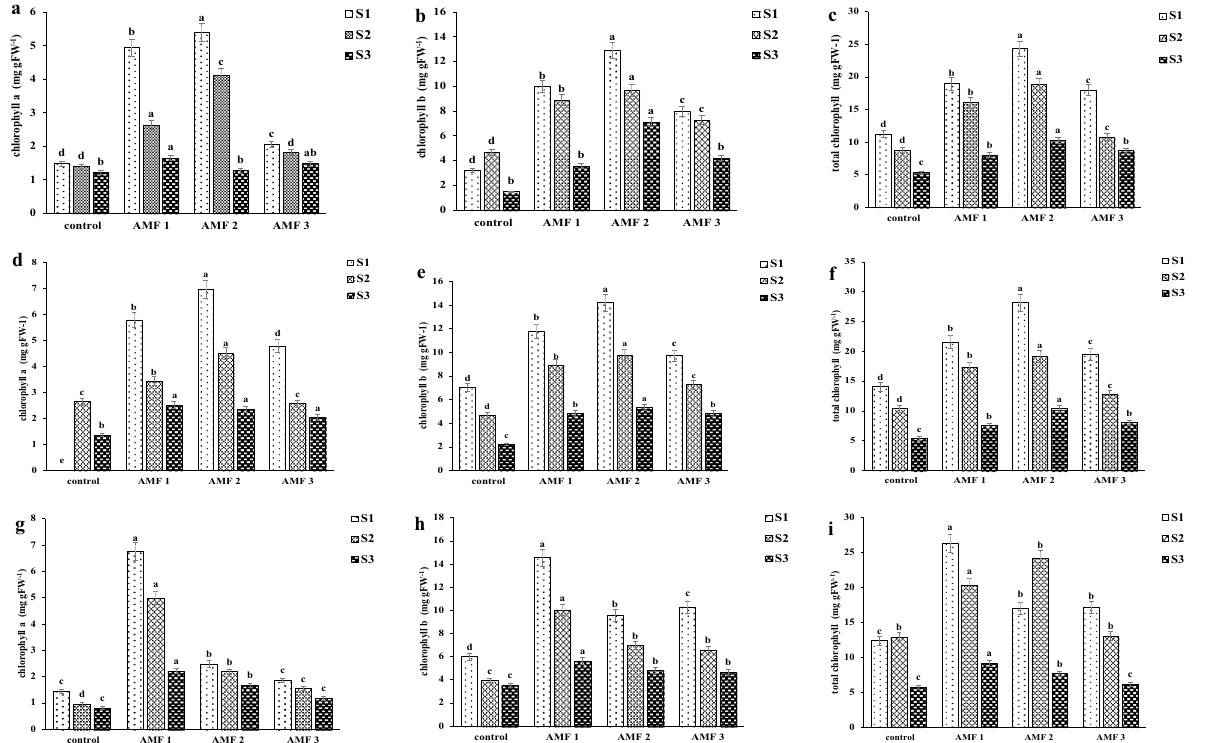
Figure 1. Effect of AMF pre-inoculation and salinity on leaf chlorophyll a (panels a , d , g ); chlorophyll b (panels b ,e, h ) and total chlorophyll concentration (panels c , f , i ) of eucalyptus three eucalyptus clones (H4; panels a – c ), H 8: panels d – f ) and P6 (panels g – i ) after cultivation for 90 days. Mean values shown, in which the same letters above the bars represent no significant difference, according to HSD at P ≤ 0.05. Abbreviation: AMF1; Glomus sp.2, AMF2; G. albida , AMF3; G. decipiens , control; not pre-inoculated with AMF, S1; 10 dS m −1 , S2; 15 dS m −1 , S3; 20 dS m −1